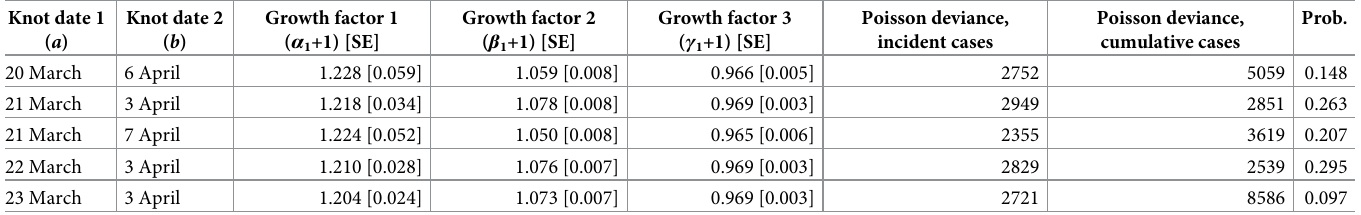
Table 1. Most likely knot date pairs.